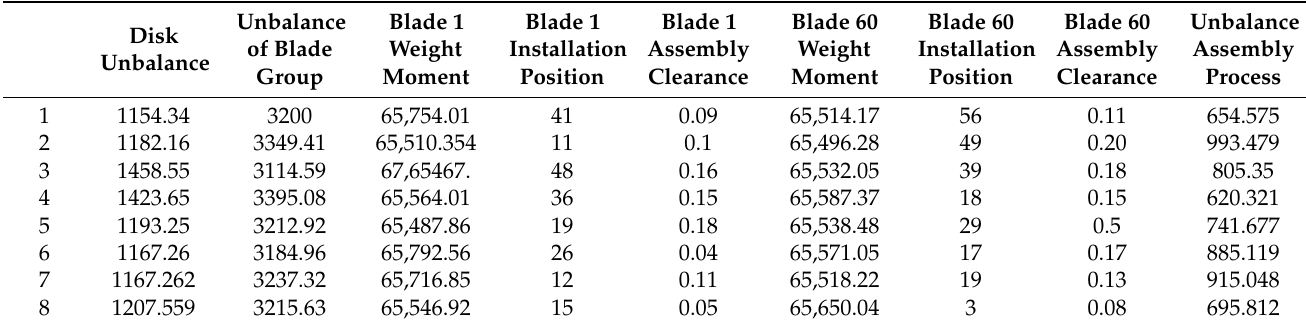
Table 7. AAE generates model results.